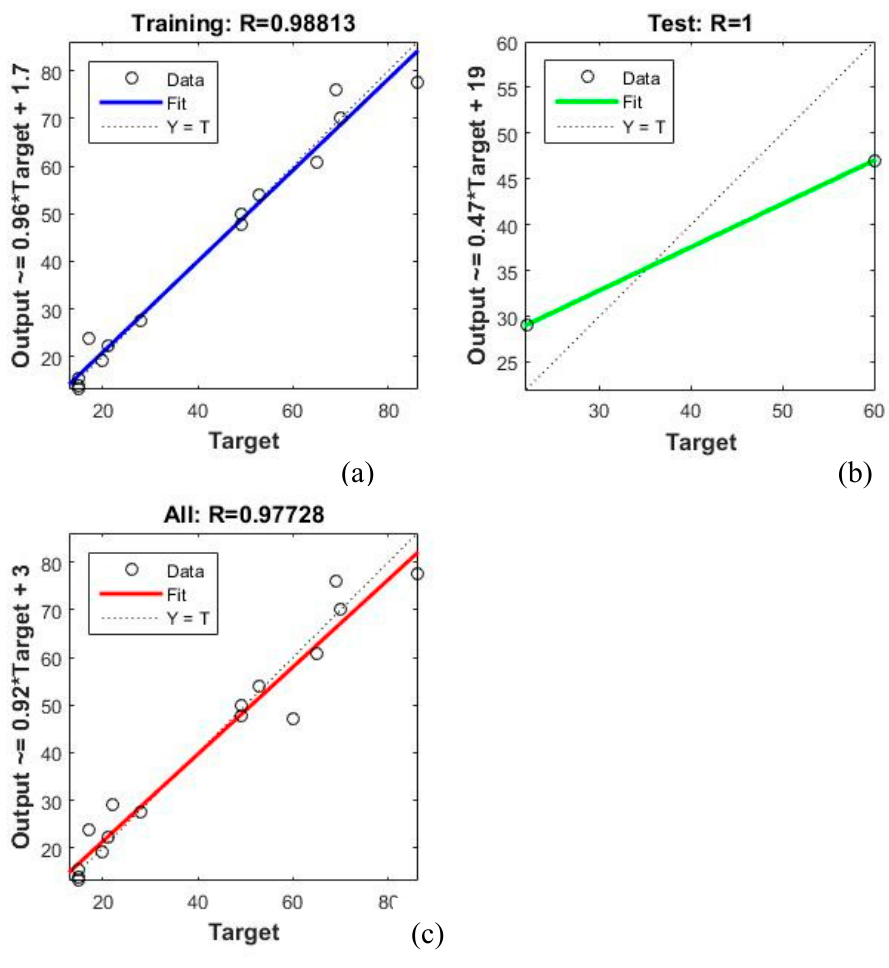
Figure 6. Output of the neural network model according to provided targets during (a) training (blue), (b) validation (green), and (c) testing (red), with corresponding correlation coefficients.